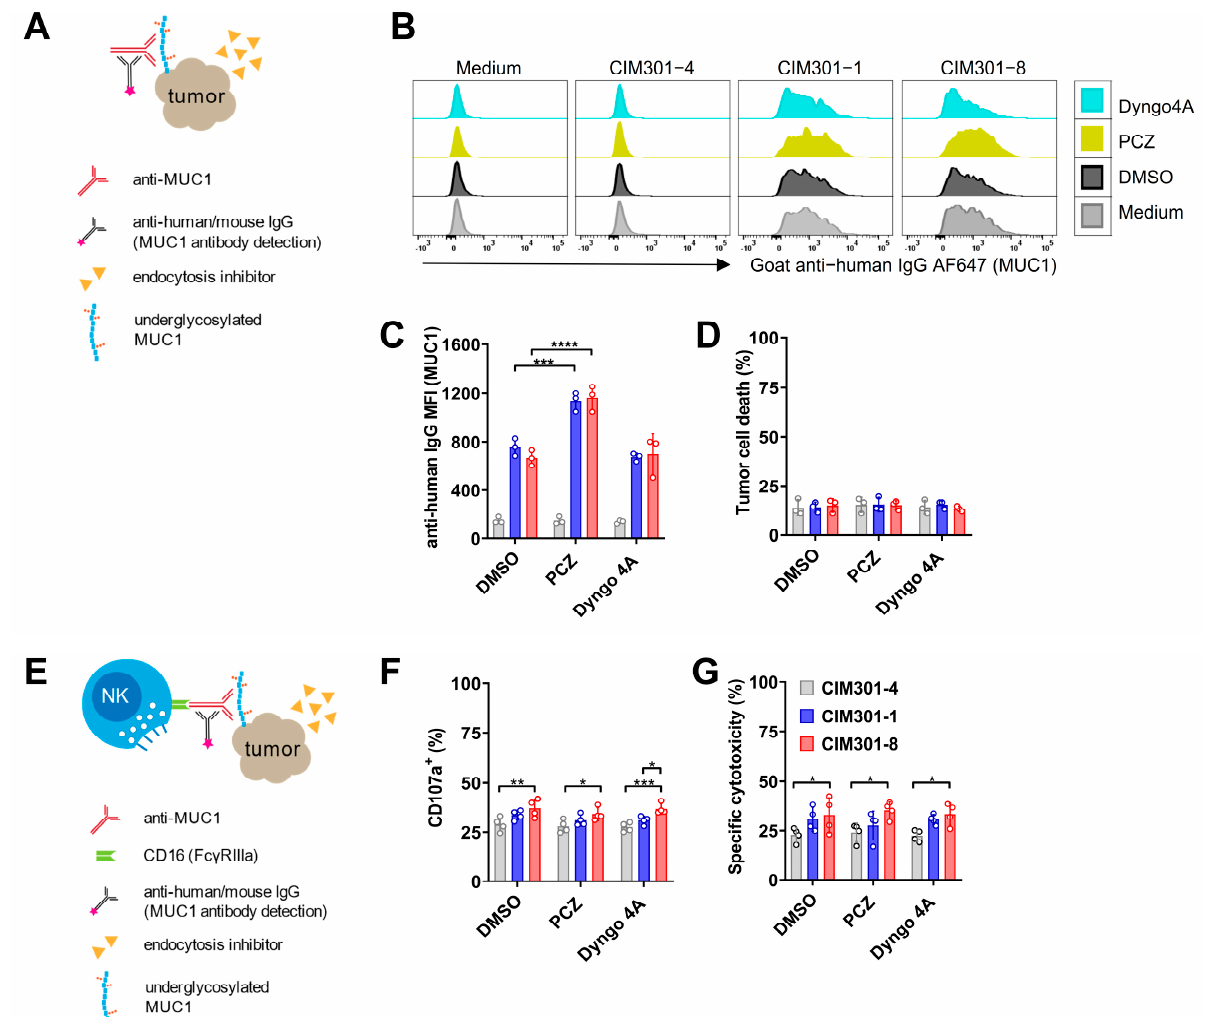
Figure 6. The endocytosis inhibitor PCZ promotes tumor antigen expression on T-47D cells but does not enhance antibody- dependent NK cell-mediated cytotoxicity. ( A ) Experimental setup to determine whether endocytosis inhibitors enhance MUC1 epitope availability on tumor cells. ( B ) Overlay histograms of flow cytometric analysis of MUC1 epitope expression on T-47D tumor cells in the presence of endocytosis inhibitors using regular (CIM301-1) or defucosylated (CIM301-8) anti-MUC1 antibodies or an irrelevant control antibody (CIM301-4). Anti-human IgG antibodies were used to detect antibody binding on tumor cells. Endocytosis inhibitors were dissolved in DMSO, here used as a negative control. One representative sample is shown. ( C ) Flow cytometric quantification of MFI of MUC1 expression levels on T-47D cells after treatment with endocytosis inhibitors as described in ( B ). Differences between control antibody (CIM301-4; grey bars) and anti-MUC1 antibodies (regular CIM301-1 in blue and defucosylated CIM301-8 in red) were all statistically significant with p < 0.0001. ( D ) Viability of T-47D tumor cells after incubation with anti-MUC1 antibodies with or without endocytosis inhibitors. Pooled data from three independent experiments performed at different timepoints. ( E ) Schematic overview of assays to test whether endocytosis inhibitors influence NK cell degranulation and cytotoxicity in the presence of anti- MUC1 antibodies. ( F ) Fraction of CD107a+ degranulating human NK cells in co-cultures with T-47D tumor cells at an effector/target ratio of 1:1 in the presence of anti-MUC1 antibodies and endocytosis inhibitors. NK cells and tumor cells were incubated for 4 h, with endocytosis inhibitors (5 µ M PCZ, 30 µ M Dyngo4A and 0.1% ( v/v ) DMSO) added during the last hour. ( G ) Antibody-dependent NK-cell-mediated cytotoxicity against T-47D tumor cells. Experimental setup as in ( F ). Panels ( F , G ) show pooled data from four independent experiments with different donors, performed at different time points. Differences between groups were determined using two-way ANOVA with Tukey’s multiple comparisons test. p < 0.05 (*); p < 0.01 (**); p < 0.001 (***); p < 0.0001